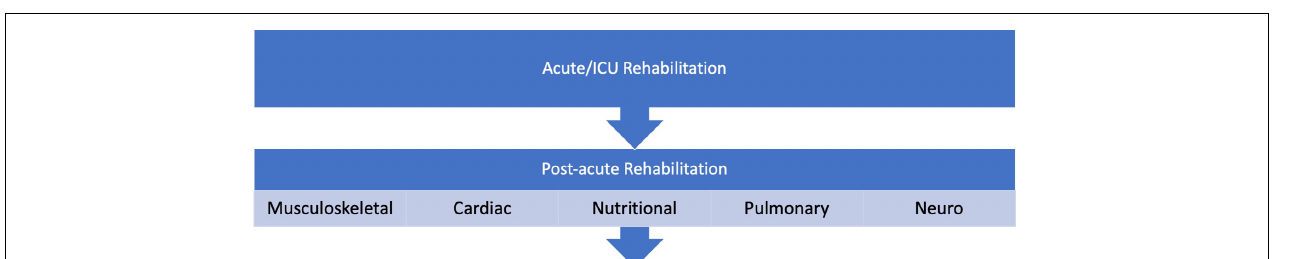
FIGURE 2 | PRISMA flow diagram.